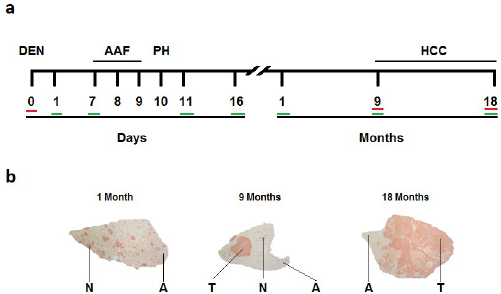
Fig 1. Tissues collected after inducing hepatocellular carcinoma in rats. ( a ) Sampling time points. Green lines under the numbers indicate collection of samples from treated rats. Red lines indicate collection of samples from untreated controls. ( b ) Gamma glutamyl transpeptidase histologic stains used to identify adjacent (A), nodular (N) or tumoral (T) tissues. DEN, diethylnitrosamine; AAF, 2-acetylaminofluorene; PH, partial hepatectomy; HCC, hepatocellular